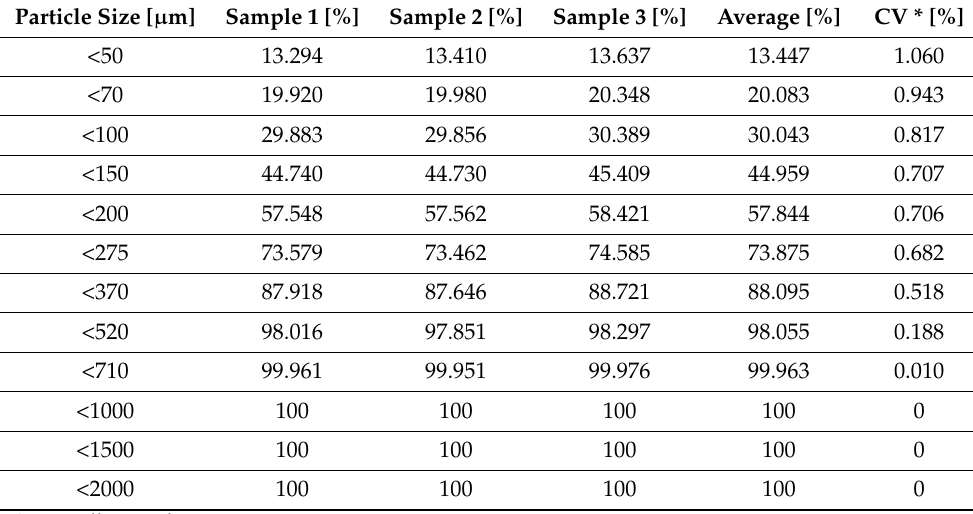
Table 6. Results of the third particle size distribution analysis in terms of cumulative frequency.